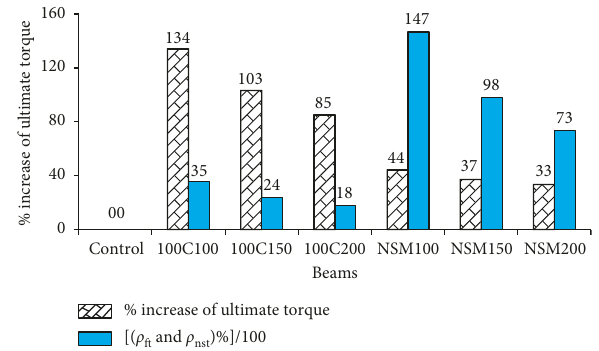
Figure 11: FRP and NSM steel reinforcement ratios and increase in ultimate torque in percentage.